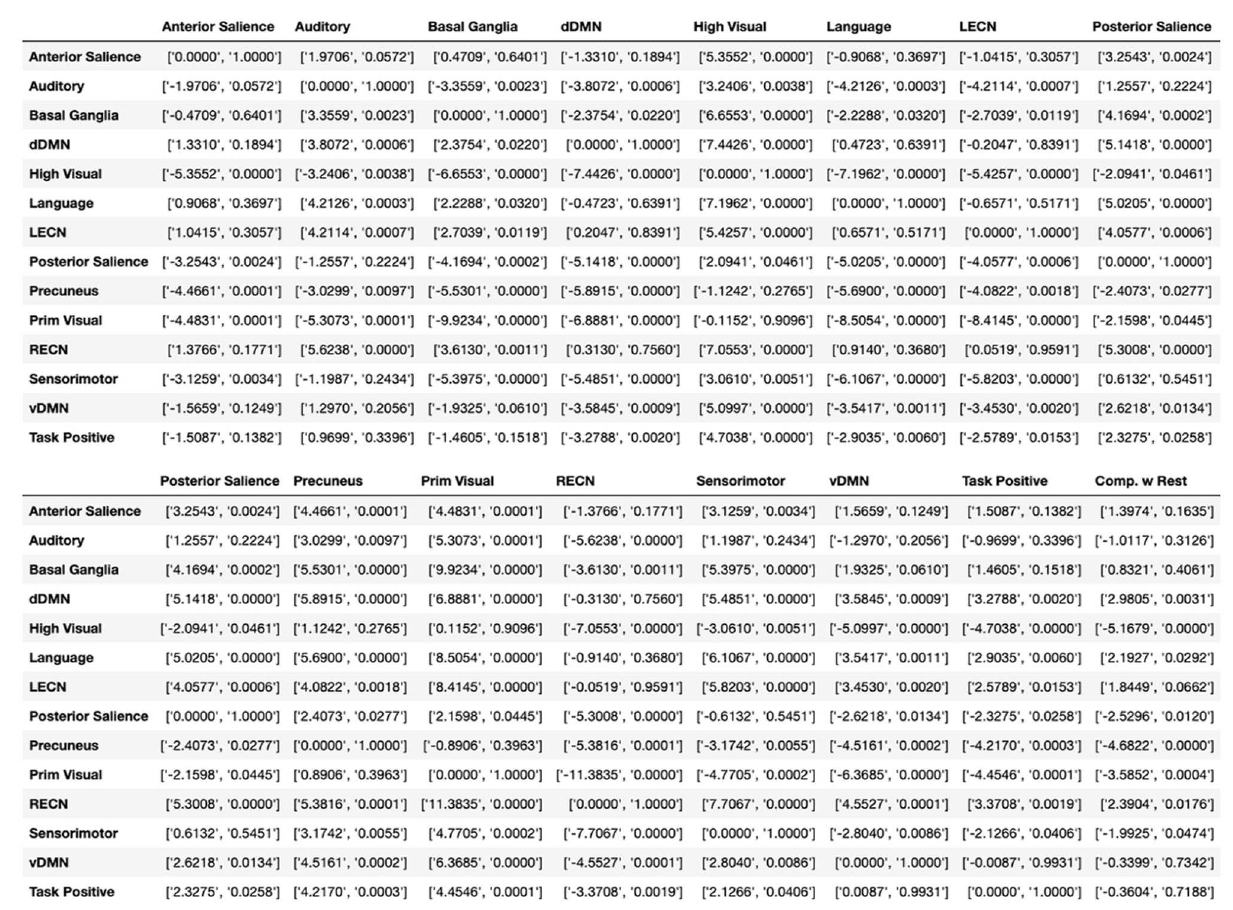
FIGURE6 Additional statistics for Figure 5. Independent t and p values between boxplot modules in Figure 5, shown as [t-value, p-value]. The last column called “Comp. w Rest” calculates the t-test between the specific module and the whole brain. For visualization purpose the table is cut to two